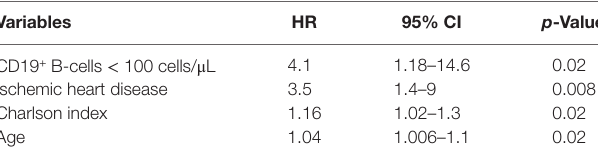
TaBle 5 | Multivariate analysis for cardiovascular deaths.